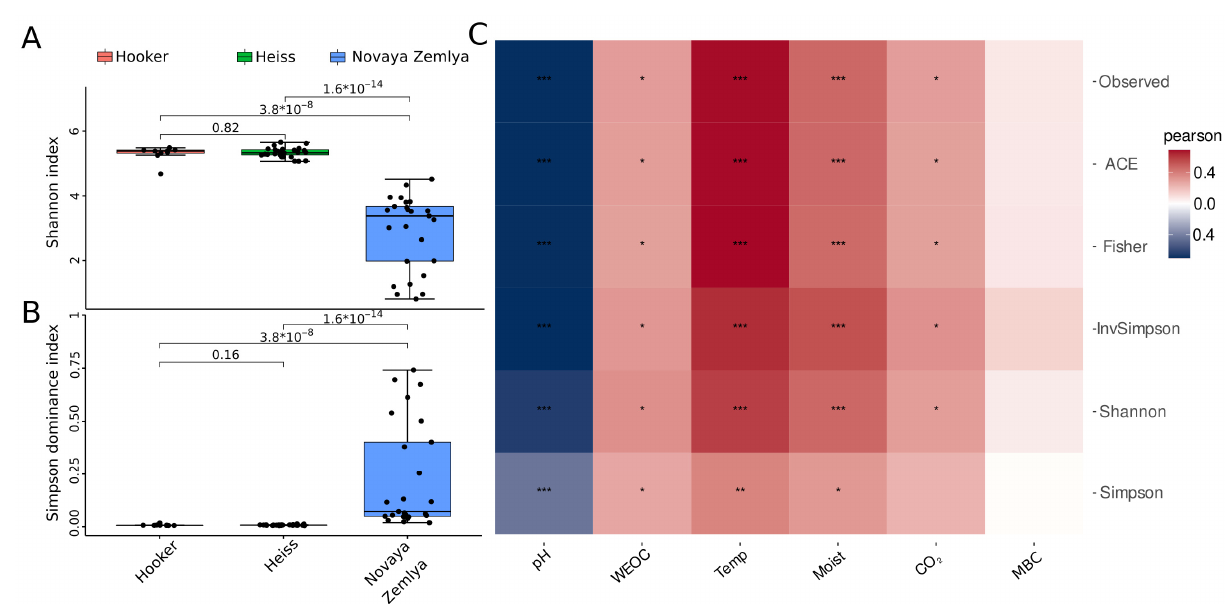
Figure 2. Visualization of alpha-diversity analysis of soil microbial communities of Barents Sea islands: ( A , B )—boxplots of diversity metrics compared between Franz Josef Land and Novaya Zemlya islands, ( C )—heatmap of Pearson’s correlation coefficients between alpha-diversity metrics and environmental parameters. WEOC—water-extractable organic carbon, Temp—temperature, CO 2 —carbon emission, Moist—moisture, MBC—microbial biomass carbon; p -values are labeled as follows: p < 0.05—*; p < 0.01—**; p < 0.001—***.